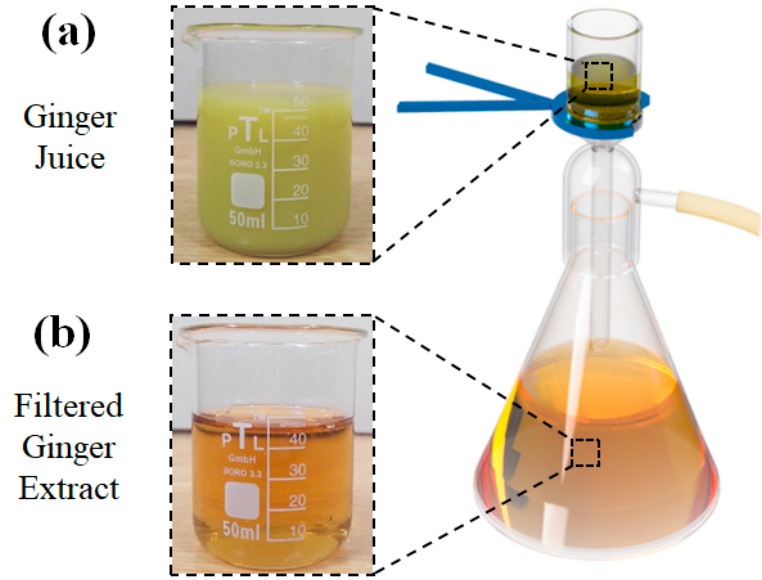
Figure 1. GE ( a ) before and ( b ) after filtration.